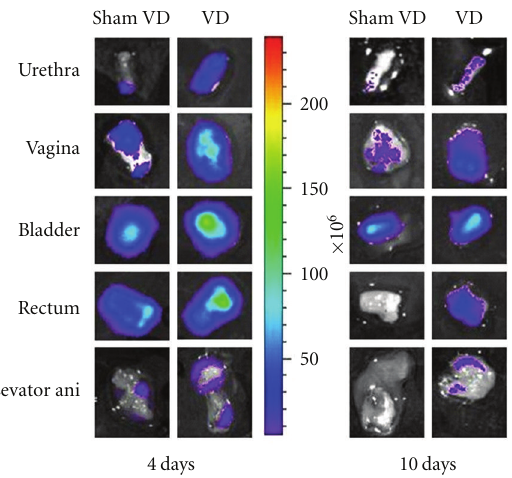
Figure 2: Examples of ex vivo fluorescence images for GFP+ mesenchymal stem cells in the urethra, vagina, bladder, rectum, and levator ani 4 and 10 days after vaginal distension (VD) and sham VD. Each column contains organs taken from a single animal. The colored scale represents total fluorescent flux (photons/second/cm 2